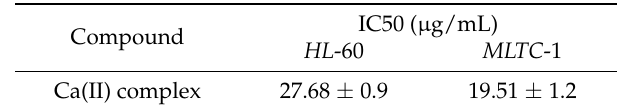
Table 3. In vitro cytotoxic activities of 1